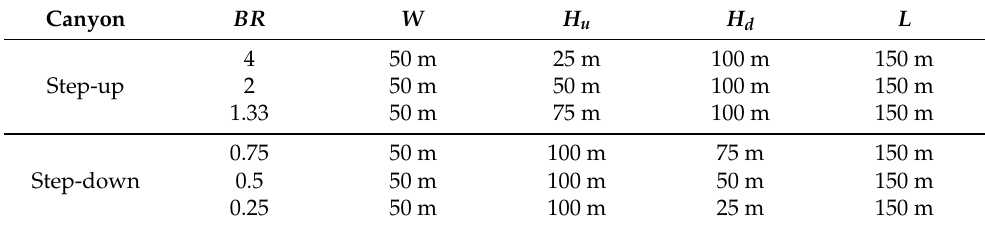
Table 2. Step-up and step-down canyon